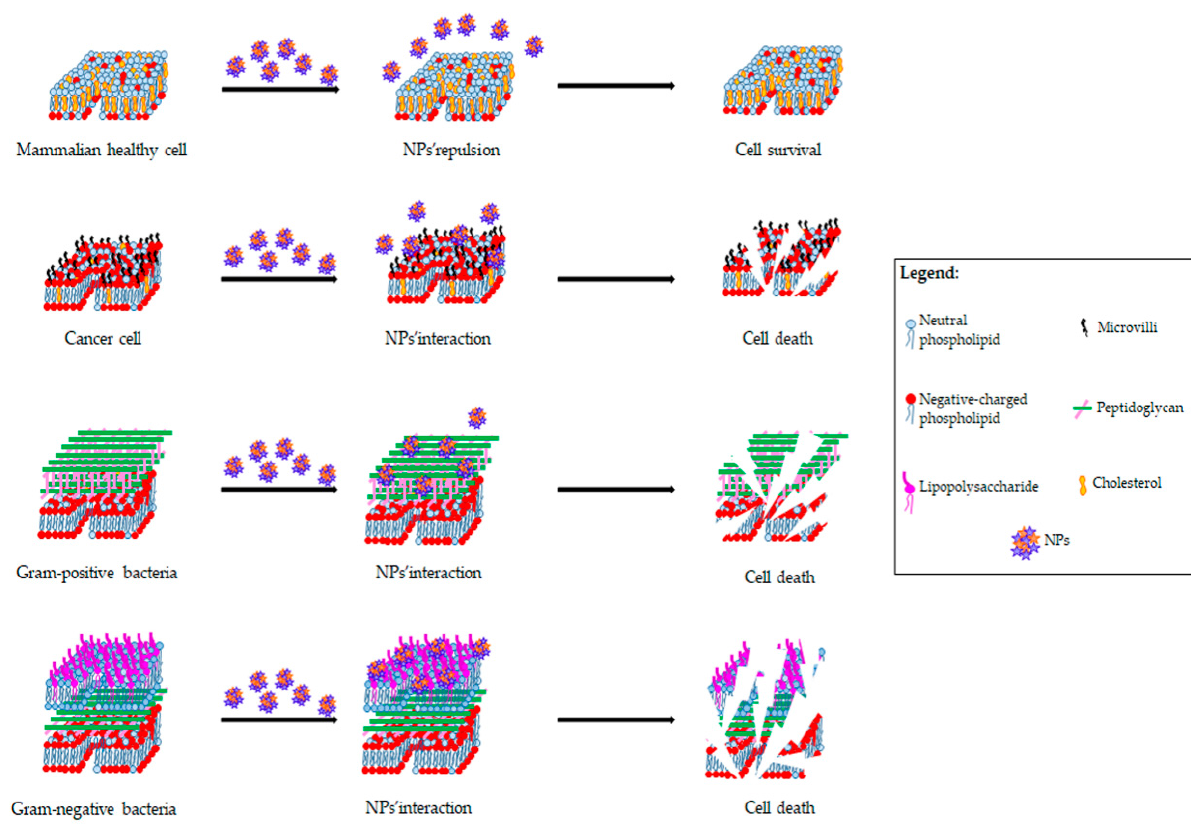
Figure 4. NPs’ interaction with cell membrane and their killing ability on cancer cells and bacteria.